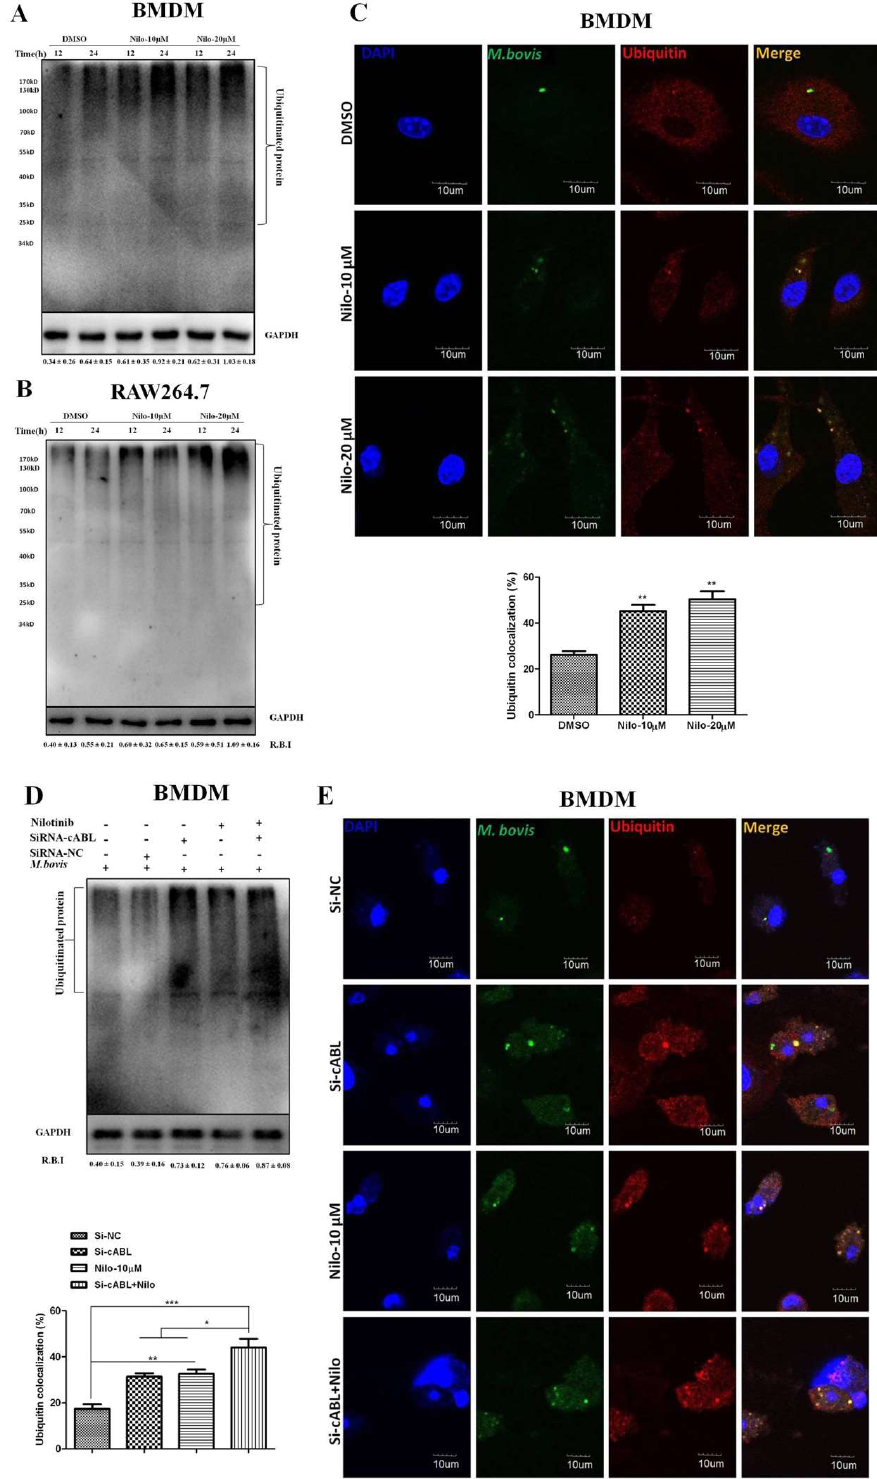
Figure 5. Nilotinib promotes the ubiquitination of M. bovis in infected macrophage. ( A , B ) BMDM and RAW264.7 cells were treated with DMSO (0.1%) or Nilotinib 10 µ M and 20 µ M followed by